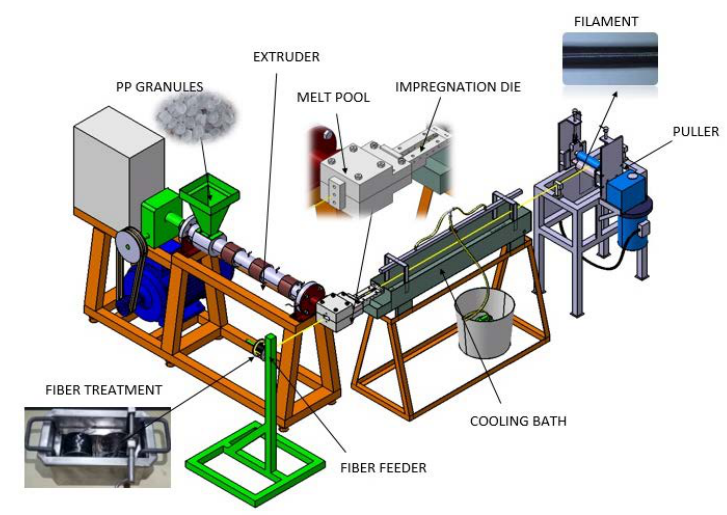
Figure 1. Schematic of the extrusion–pultrusion machine.